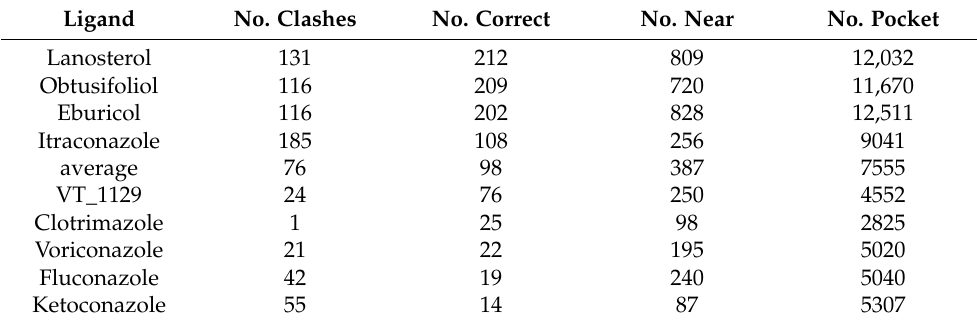
Table 1. Analysis of Tremellomycetes CYP51s and ligand complexes. Number of models falling into ‘clashes’, ‘correct’, ‘near’, and ‘pocket’ group summarized by ligands. These numbers are summed up over all 11 proteins, so the total number of models for each inhibitor is 99,000.